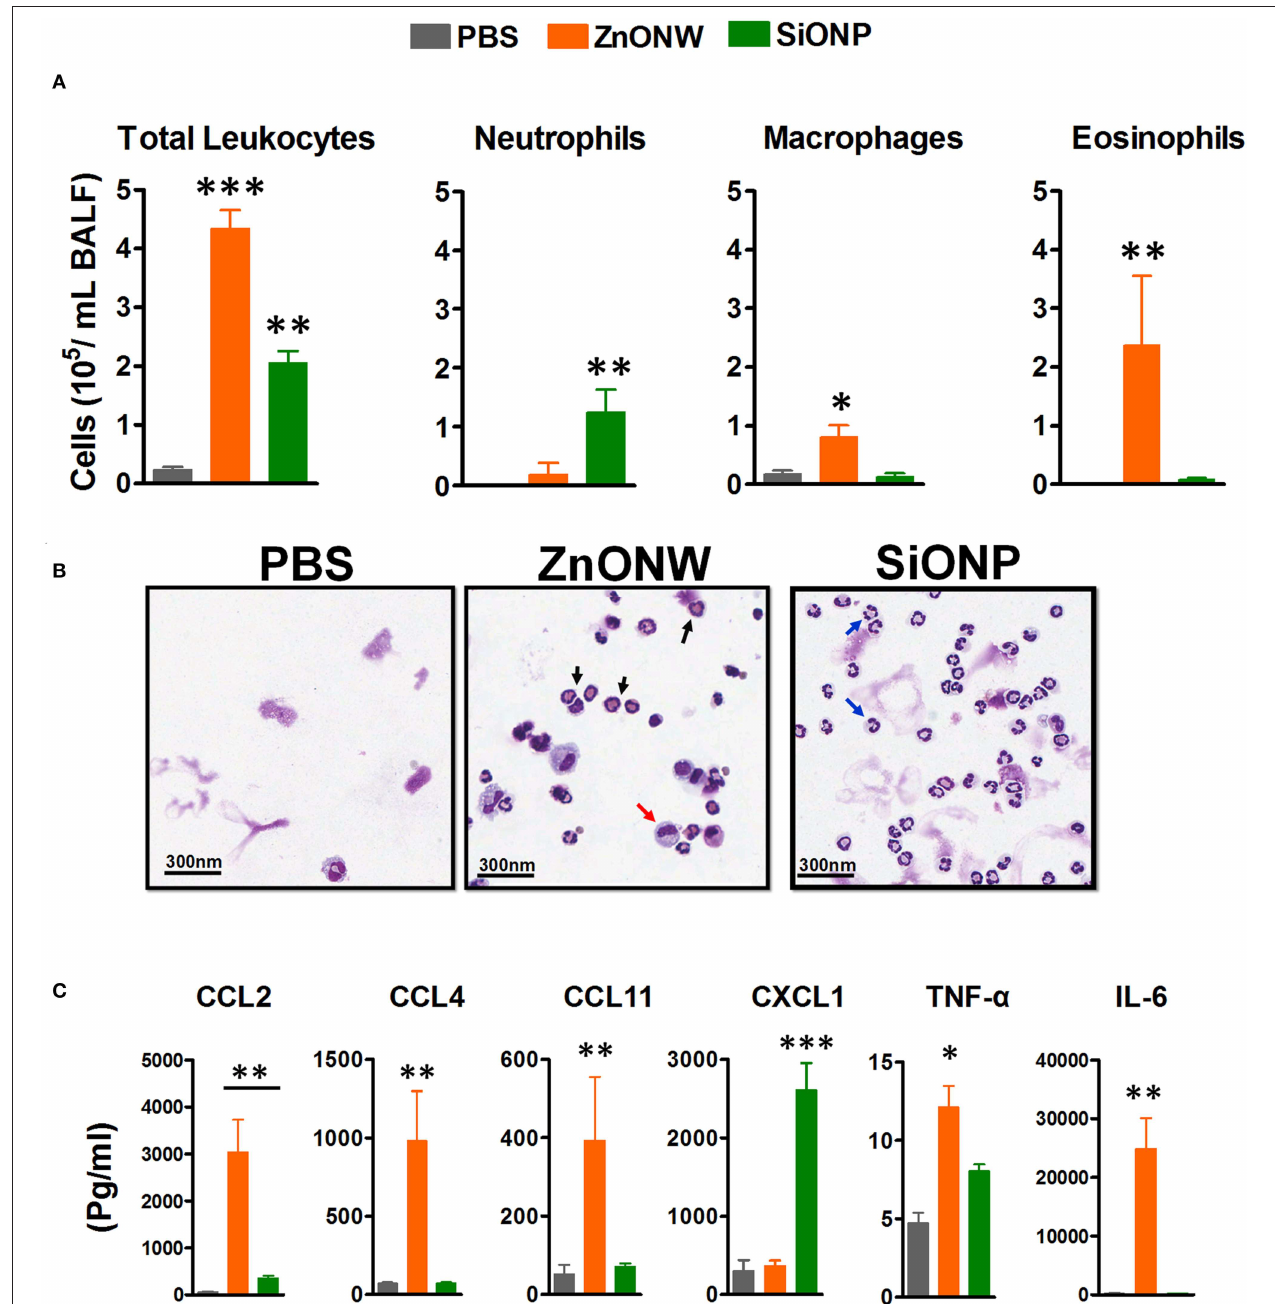
FIGURE 5 | Nano-particle induced acute lung inflammation. WT mice were intratracheal instilled with nanoparticles (ZnONWs or SiONPs) or PBS as described in methods. Lungs were lavaged with 3ml of buffer to assess infiltrating immune cells as identified by flow cytometry of BALFs (A) . Total number of leukocytes and differential count for cell types recruited in the lung are indicated above. Data are representative of at least five mice per group. Representative cytospin slides showing macrophages (red arrow), neutrophils (blue arrow), and eosinophils (black arrow) (B) . Cytokines and chemokines levels were analyzed in BALFs from PBS or particles treated mice using Multiplex analysis. Levels of inflammatory proteins IL-6, TNF- α , CCL2, CCL3, CCL4, CCL11, CXCL1, and CXCL2 are shown (C) . Data represent at least five mice per group; error bars denote mean ± SEM. * P < 0.03, ** P < 0.009, *** P < 0.0007; Unpaired t -test.